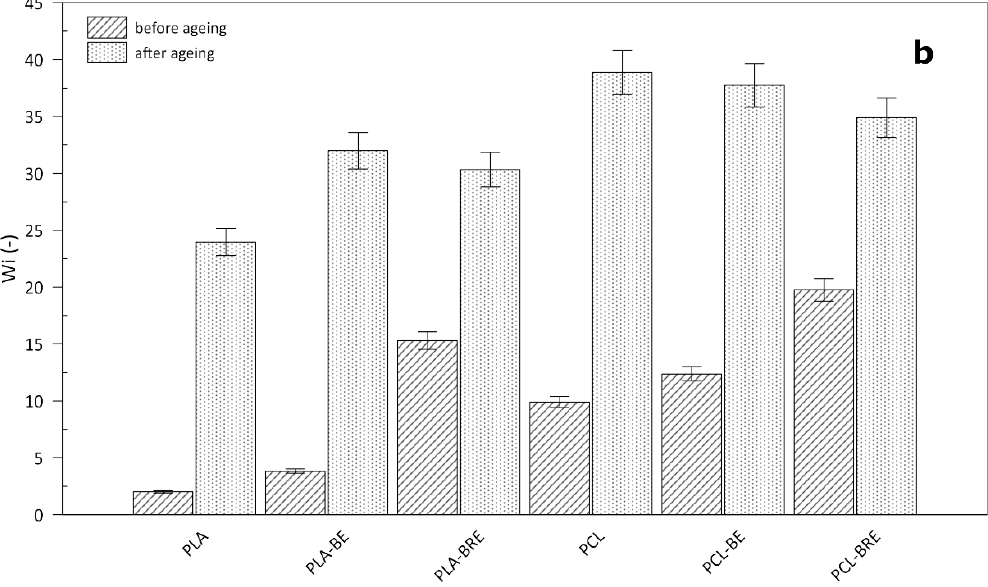
Figure 10. Impact of solar ageing on ( a ) chroma (C ab ) and ( b ) the whiteness index (W i ); calculations were performed according to Equations (3) and (4).